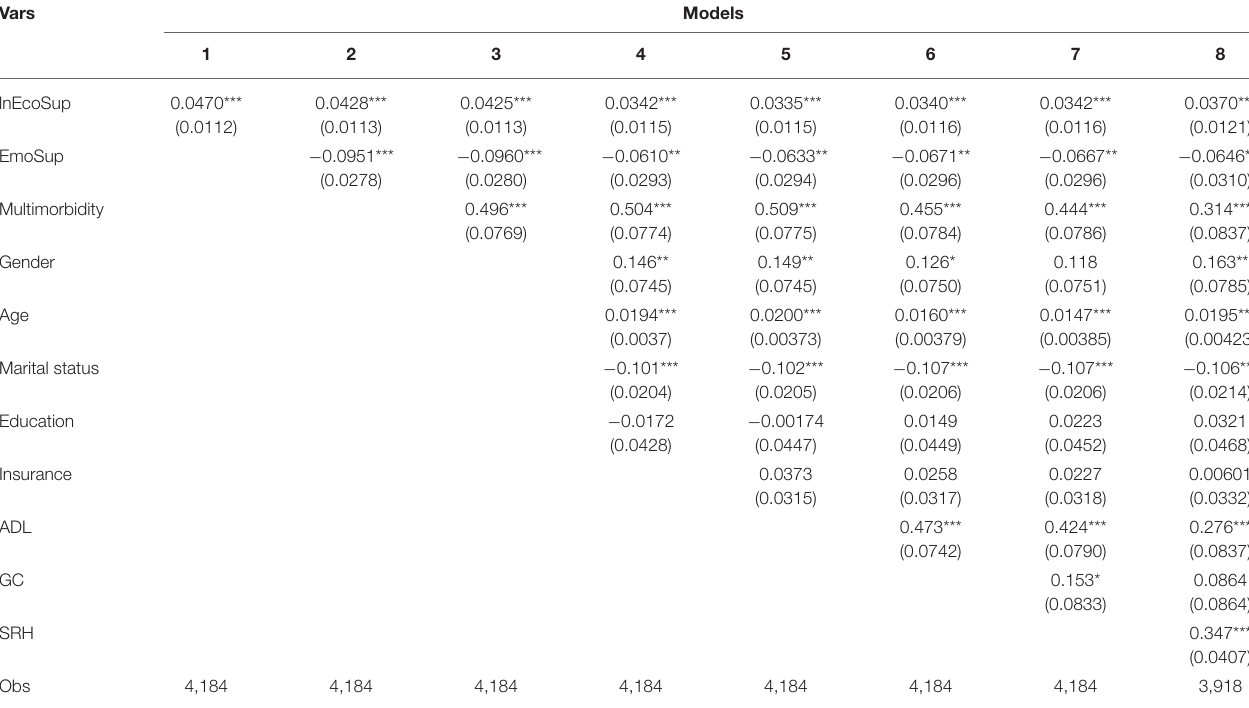
TABLE 3 | Stepwise regression results ( z = 0.4).